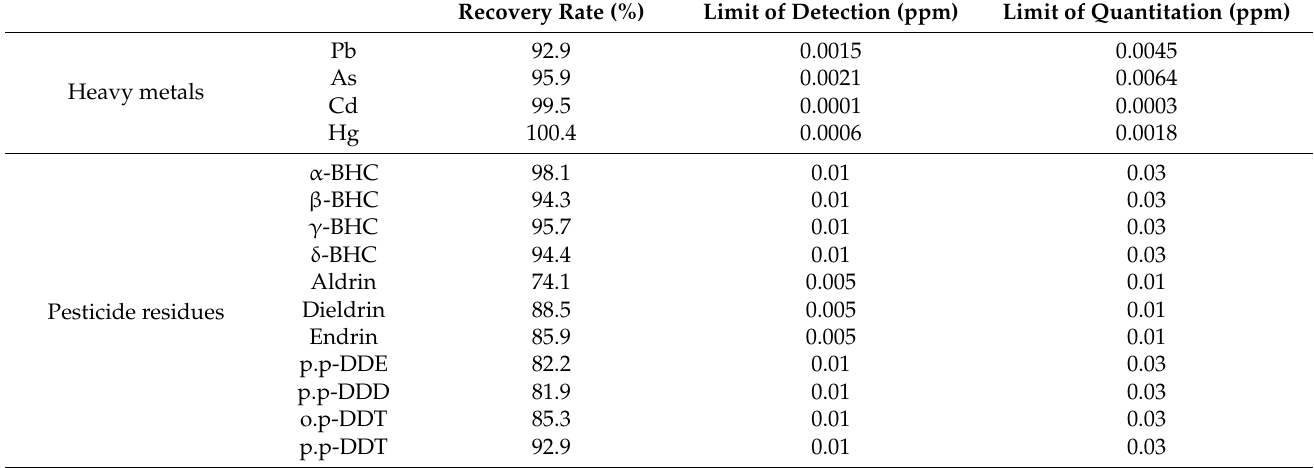
Table 4. Recovery rate, detection limit, and quantitation limit of analysis equipment. Recovery Rate (%) Limit of Detection (ppm) Limit of Quantitation